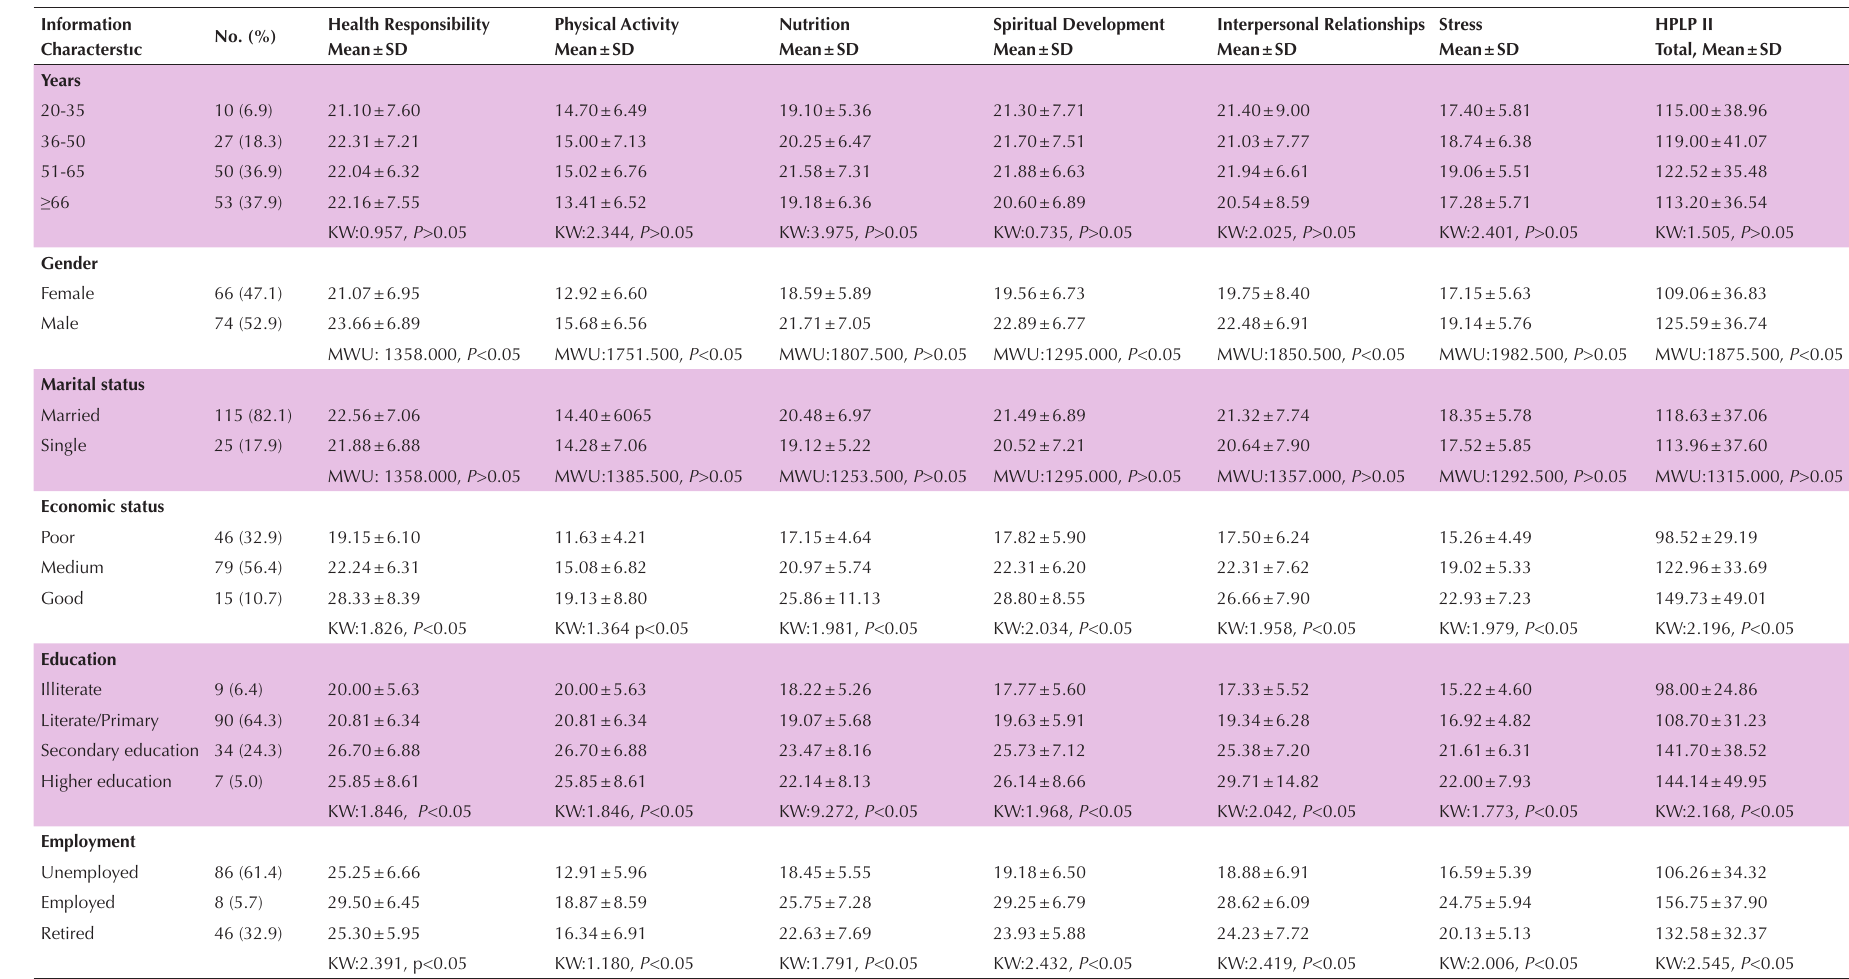
Table 2. The distribution of the mean average of the patients in the HLPL according to some ınformation characteristic Information